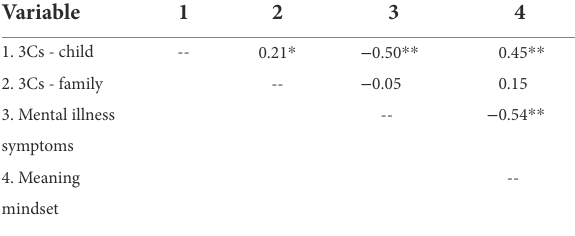
TABLE 2 Correlations between the 3Cs factors, mental health, and meaning mindset (English).